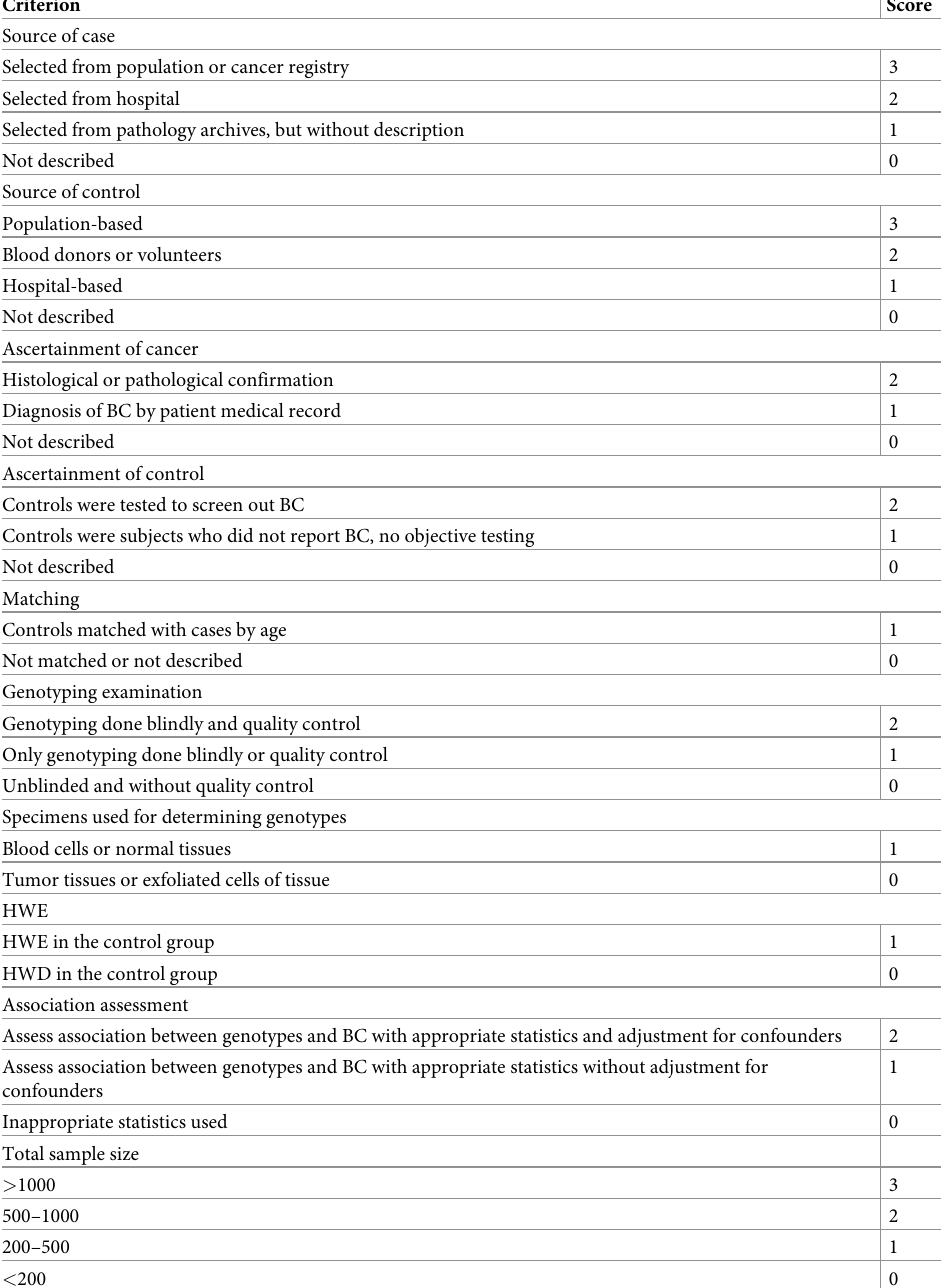
Table 1. Scale for quality assessment of molecular association studies of BC. Criterion Score Source of case Selected from population or cancer registry 3 Selected from hospital 2 Selected from pathology archives, but without description 1 Not described 0 Source of control Population-based 3 Blood donors or volunteers Hospital-based Ascertainment of cancer